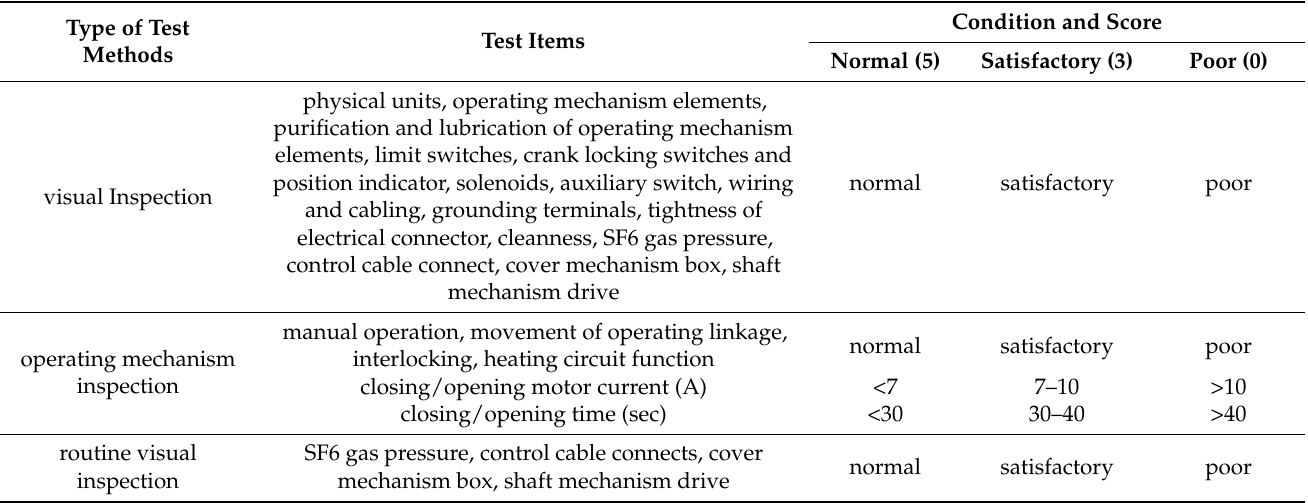
Table 4. DS/ES/HS testing methods and visual